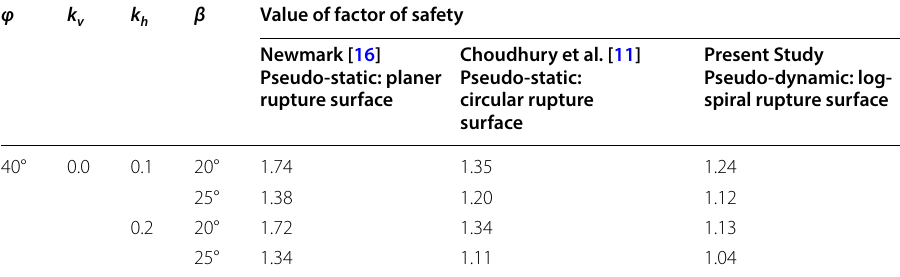
Table 3 Comparison of present results with the results obtained from pseudo-static analyses in available literature for c / γ H φ k v k h β Value of factor of safety